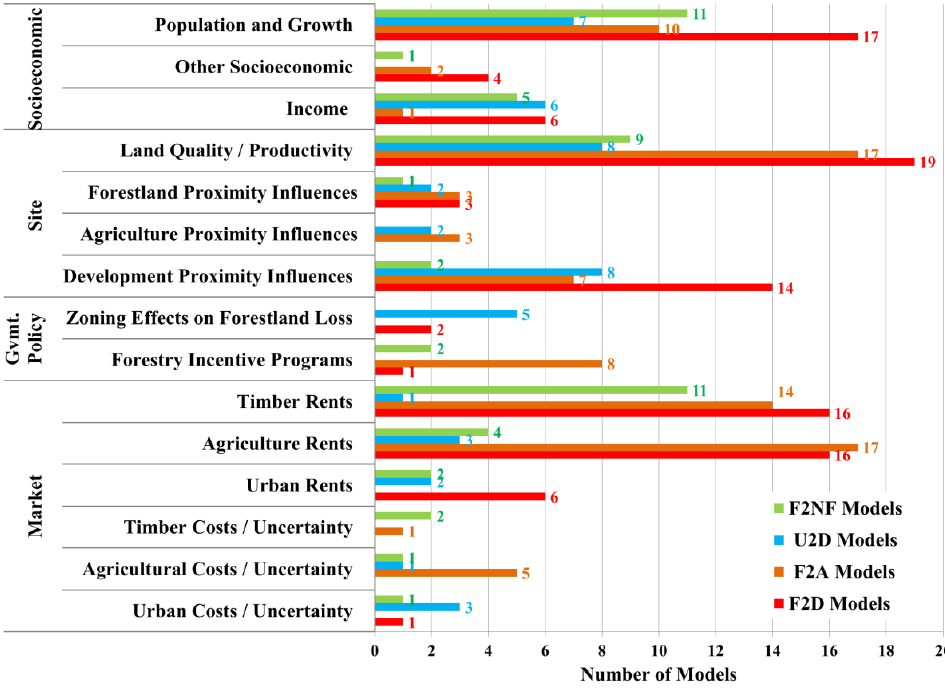
Figure 4. Frequency of models by major econometric driver and categories included in a meta-analysis of 64 econometric models predicting forestland